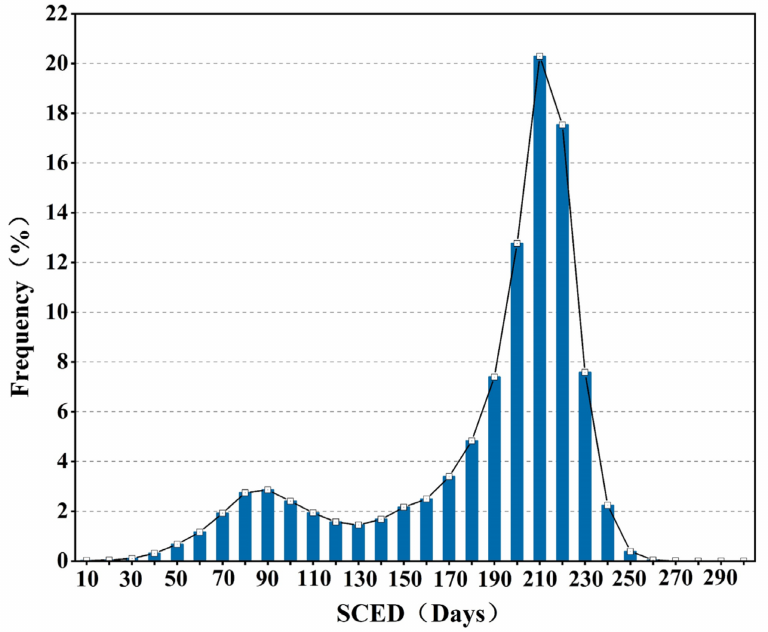
Figure 10. Histogram of annual average SCED from HY2001 to HY2017 in Northeast